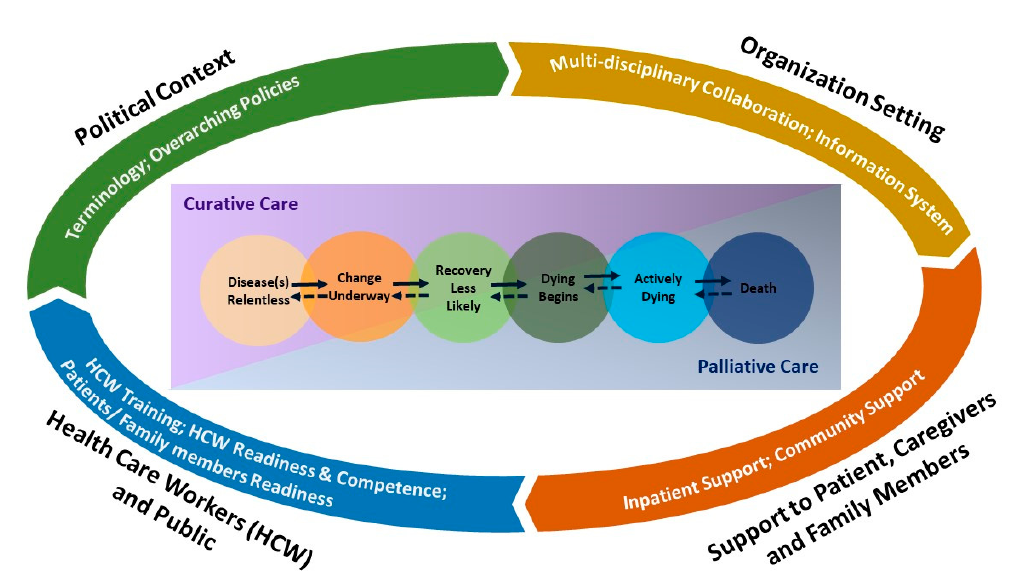
Figure 1. Thematic framework of palliative and end-of-life care service model.